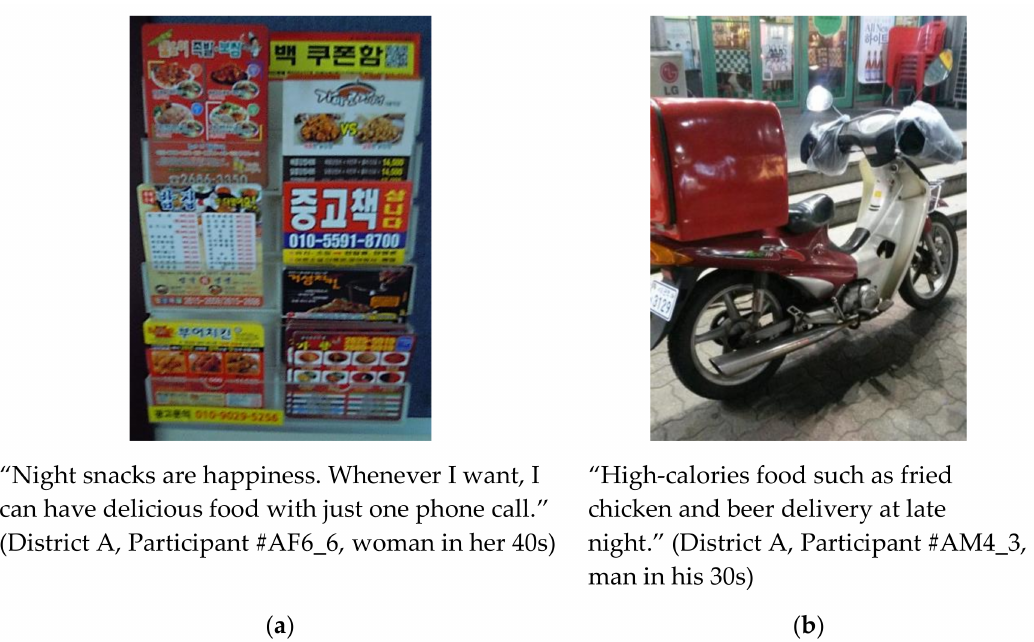
Figure 2. Pictures and statement depicting a convenience store and its products.